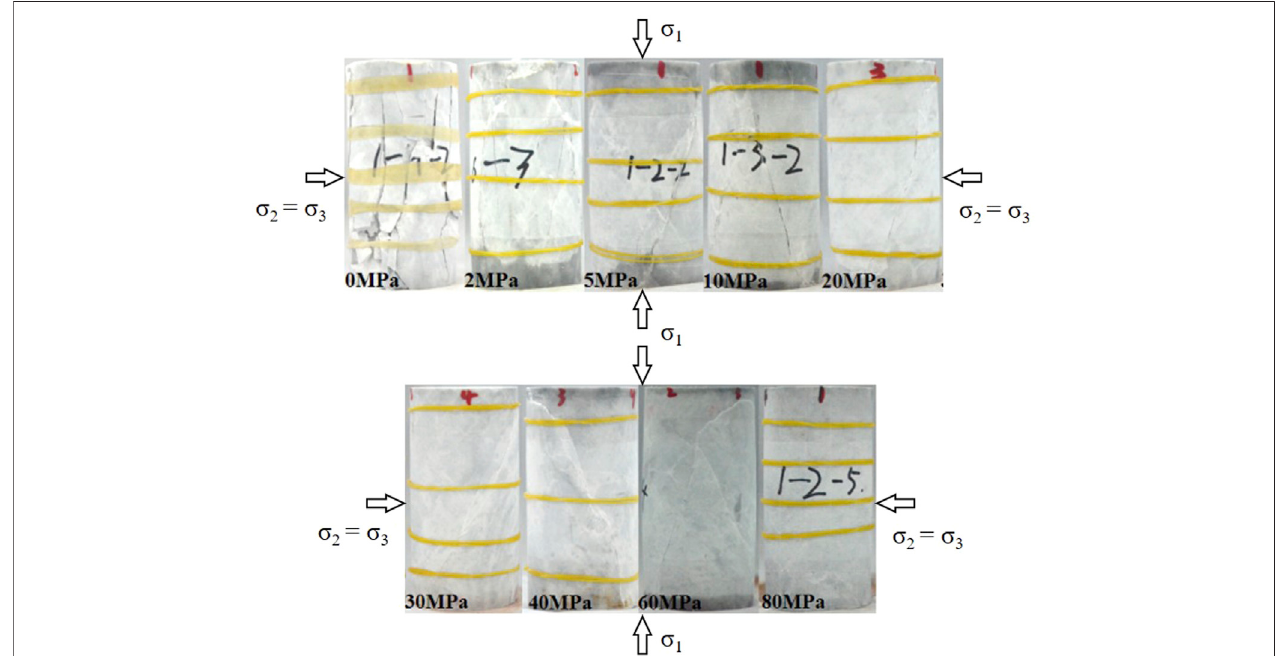
FIGURE 6 | Schematic diagram of granite samples used in the true triaxial experiment. (A) Sample physical drawing, (B) sample SEM image, (C) plane polarized light micrograph of sample, and (D) crossed polars micrograph of sample (quartz = Qtz, K-feldspar = Kfs, plagioclase = Pl, biotite = Bt).